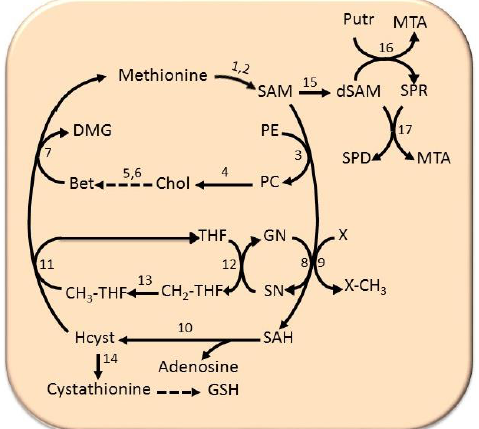
Figure 7. Methionine cycle. Substrates: CH 2 -THF, 5’-methenyltetrahydrofolate, CH 3 -THF, 5’-methyltetrahydrofolate, Chol, choline, DMG, dimethylglycine, dSAM, decarboxylated SAM, Bet, betaine, GN, glycine, Hcyst, homocysteine, MTA, 5’-methythioadenosine, PC, phosphatidylcholine, PE, phosphatidylethanolamine, Putr, putrescine, SAH, S-adenosylhomocysteine, SAM, S-adenosylmethionine, SN, sarcosine, SPD, spermidine, SPR, spermine, THF, tetrahydrofolate, X-CH 3 , methylated compound, X, unmethylated compound. Enzymes: 1, MATI / III; 2, MATII; 3, phospholipid N-methyltransferase; 4, various phospholipases; 5, choline oxidase; 6, betaine aldehyde dehydrogenase; 7, betaine homocysteine methyltransferase; 8, glycine N-methyltransferase; 9, various methyltransferases; 10, S-adenosylhomocysteine hydroxylase; 11, methyltetrahydrofolate reductase; 12, sarcosine dehydrogenase; 13, 5,10-methenyl-tetrahydrofolate reductase; 14, cystathionine synthetase; 15, S-adenosylmethionine decarboxylase; 16, ornithine decarboxylase; 17, spermine synthetase; 18, spermidine